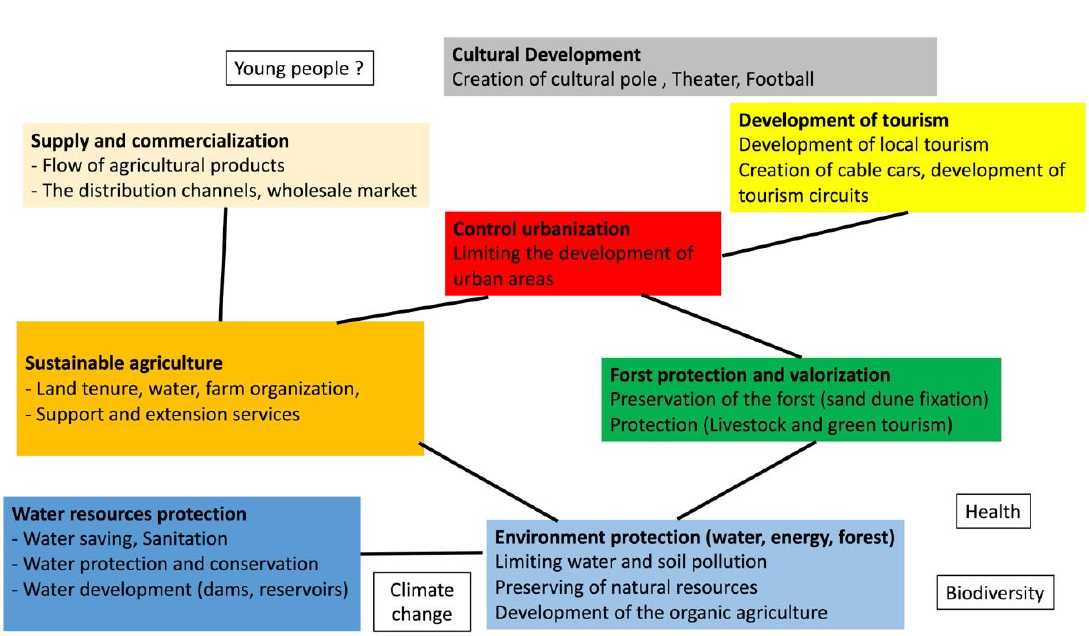
Figure 7. Classification of participants’ propositions of actions according to the eight main